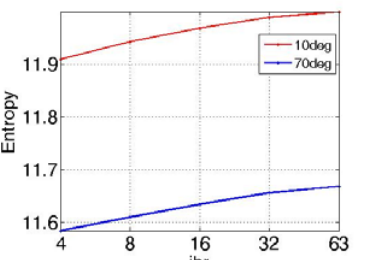
Figure 5: Entropy values as a function of ibr for 10° and 70° illumination